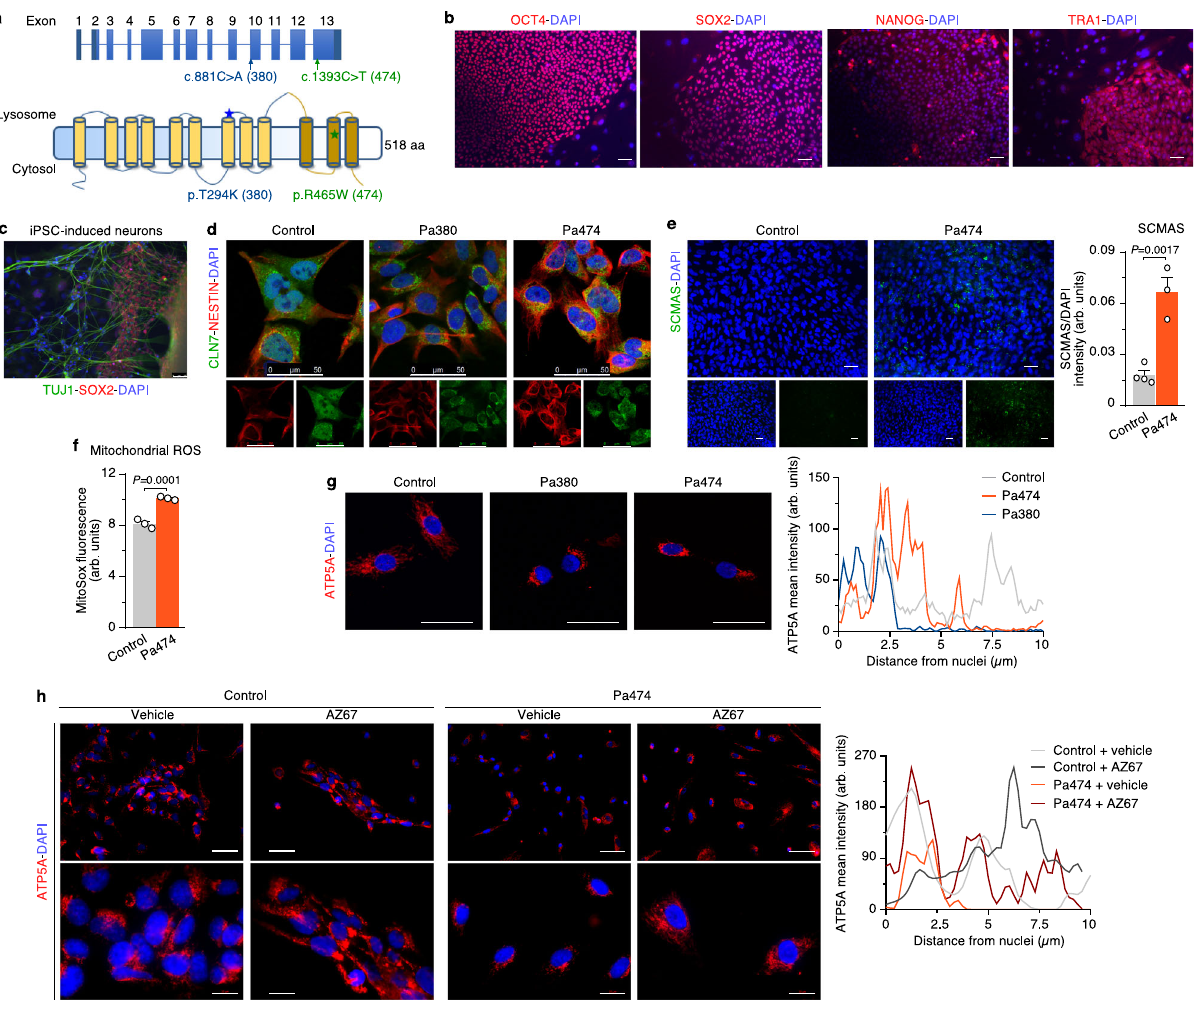
Fig. 6 PFKFB3 inhibition in CLN7 patient-derived neural precursor cells restores mitochondrial condensation. a Schematic representation of the locations of the CLN7 mutations found in patient 380 (Pa380, c.881 C > A; pT294K) and patient 474 (Pa474, c.1393 C > T; p.R465W). b iPSC characterization in Pa474 with the pluripotency markers OCT4, SOX2, Nanog, and Tra-1-60. Scale bar, 50 µ m. c Characterization of differentiated neurons derived from iPSC in Pa474. Scale bar, 50 µ m. d NPCs characterization in Pa380, Pa474, and a healthy, age-matched control individual. Scale bar, 50 µ m. e Immunocytochemical analysis of SCMAS abundance in NPCs derived from Pa474 iPSC. Data are the mean ± SEM values from n = 4 (control), n = 3 (Pa474) independent samples (two-tailed Student ’ s t test). Scale bar, 50 µ m. f Mitochondrial ROS analysis in NPCs. Data are the mean ± SEM values from n = 3 independent samples (two-tailed Student ’ s t test). g Immunocytochemical analysis of mitochondrial marker ATP5A in NPCs derived from Pa380, Pa474, and healthy-matched control patients. Scale bar, 50 µ m. The right panel shows a representative pixel intensity pro fi le of ATP5A across the maximal axis of the cell that departs from the nucleus. h Representative image of NPCs derived from Pa474 iPSC incubated with AZ67 for 24 h, fi xed and subjected to immunocytochemical analysis for ATP5A. Scale bars, 60 µ m (upper images of each condition) and 20 µ m (lower images of each condition). The right panel shows a representative pixel intensity pro fi le of ATP5A across the maximal axis of the cell that departs from the nucleus. Source data are provided as a Source Data fi